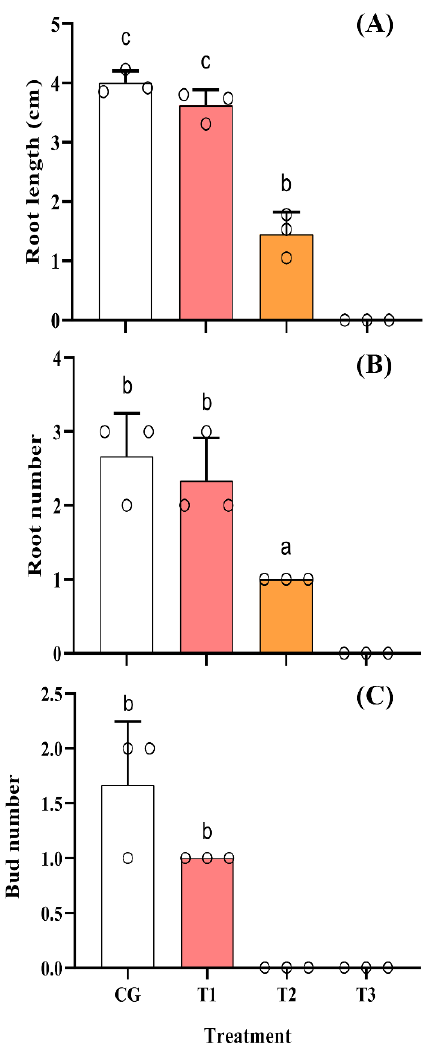
Figure 1. The mean adventitious root length ( A ) and number ( B ), and bud number ( C ) of M. spicatum in each treatment on day 5 (data points). CG: control group; T1: 0.1 times of original decomposing liquid; T2: 0.2 times of original decomposing liquid; T3: 0.4 times of original decomposing liquid. Error bars represent standard deviation (n = 3). The different letters on top of the columns indicate significant differences among treatments at the 0.05 significance level (Tukey HSD). Each dot represents a replicate.